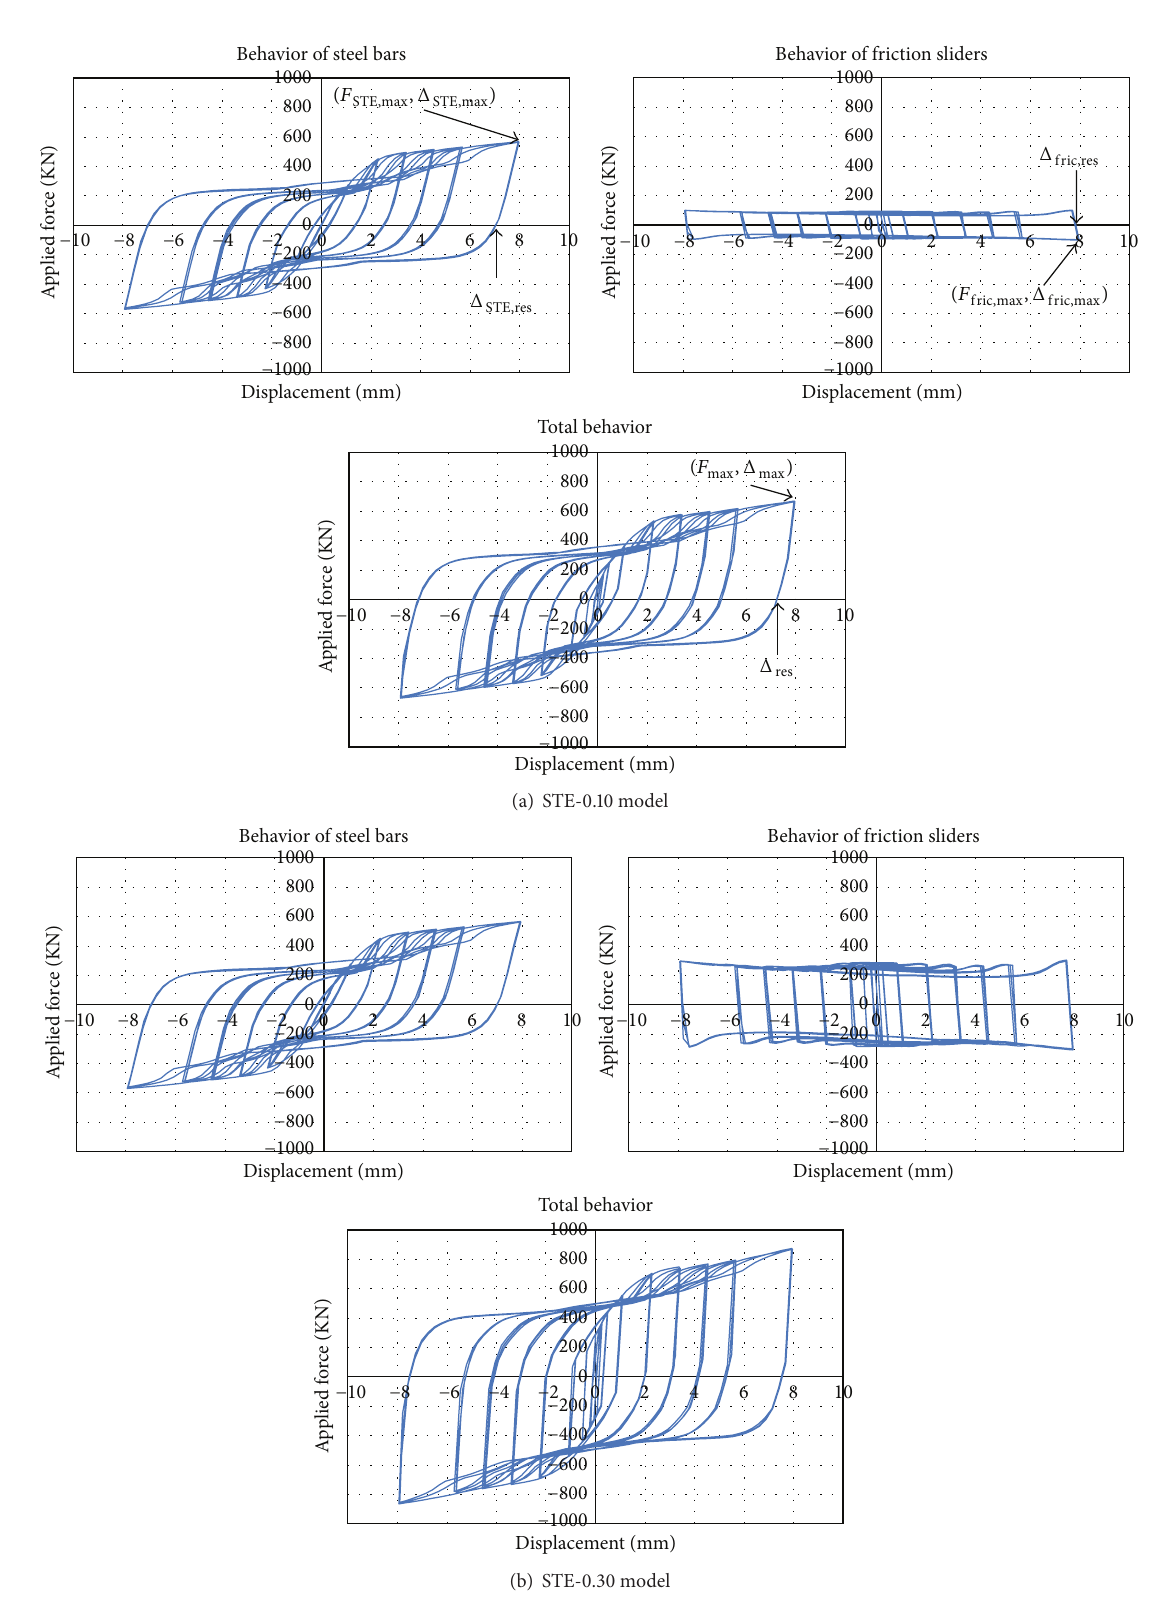
Figure 12: Simulated curves for the behavior of individual components and the total behavior of the specific model cases (STE-0.10 and STE-0.30